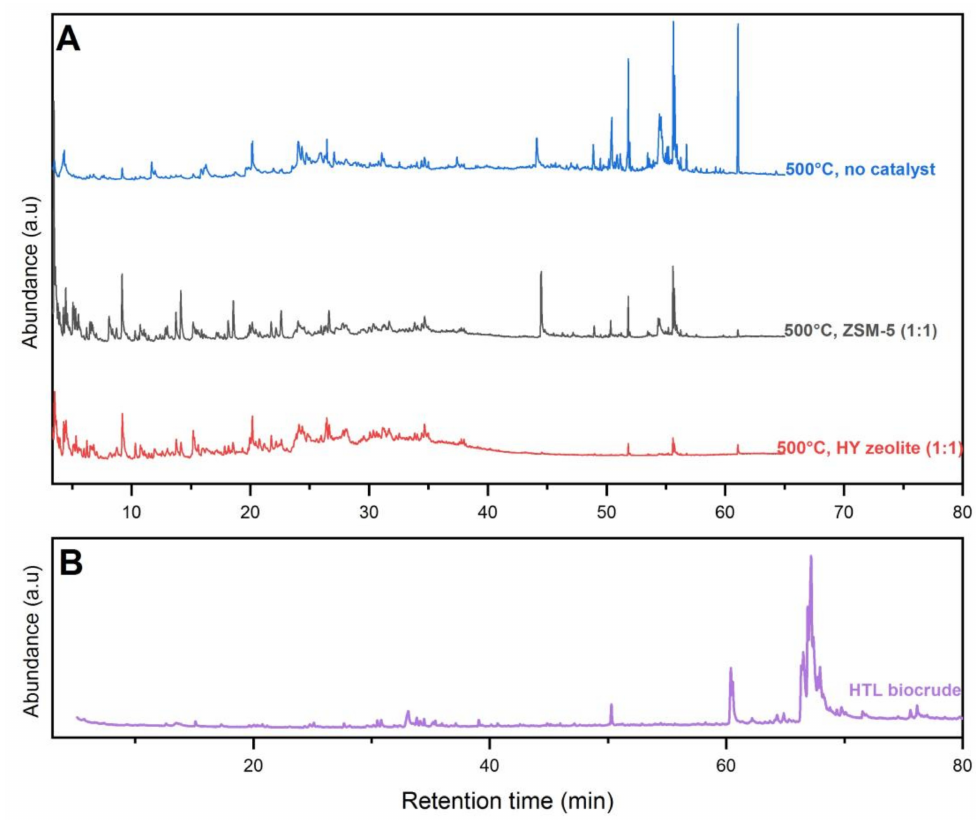
Figure 4. Comparison of total ion chromatograms (TIC) for the products of the thermal and catalytic pyrolysis of HTL biocrude (over ZSM-5 and HY zeolite) investigated through Py-GC-MS analysis ( A ), and TIC for biocrude ( B